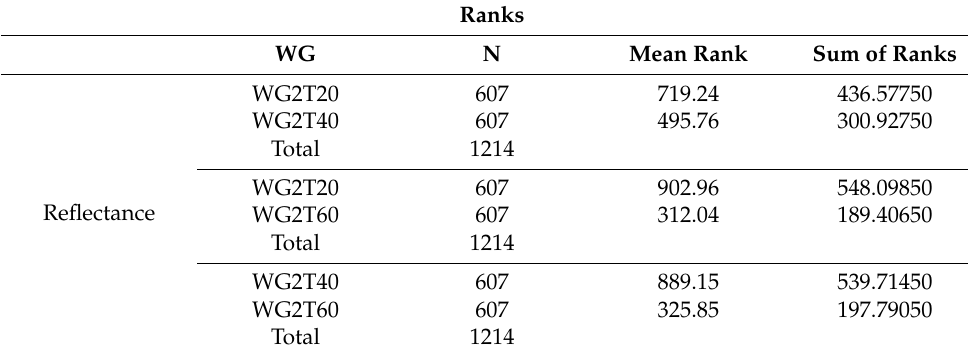
Table A17. Ranks table of Mann–Whitney U test for specular solar reflectance of WG2 during the three holding